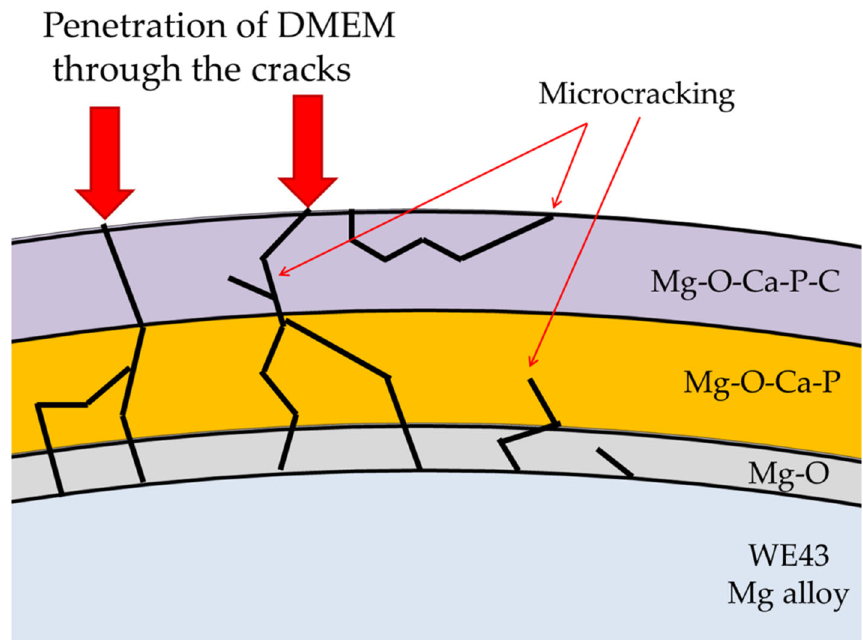
Figure 6. Schematic illustration of the three-layer corrosion product with microcracks in all cor- roded samples.